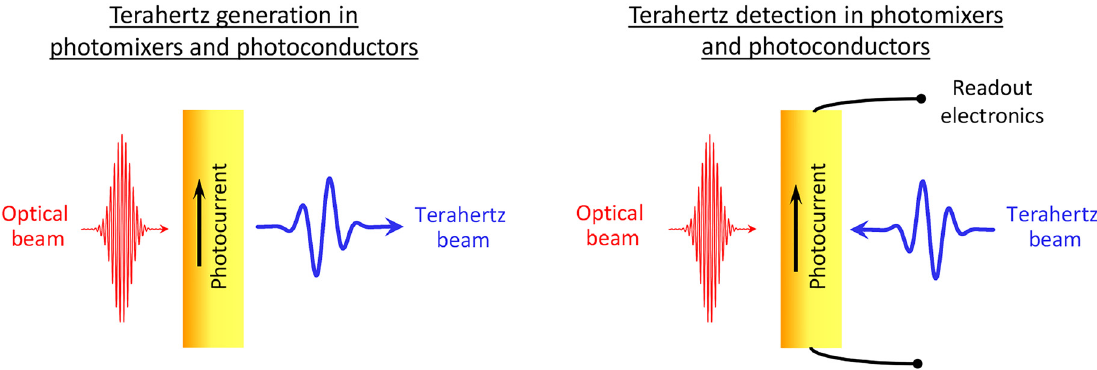
Figure 1: Terahertz generation and detection in photomixers and